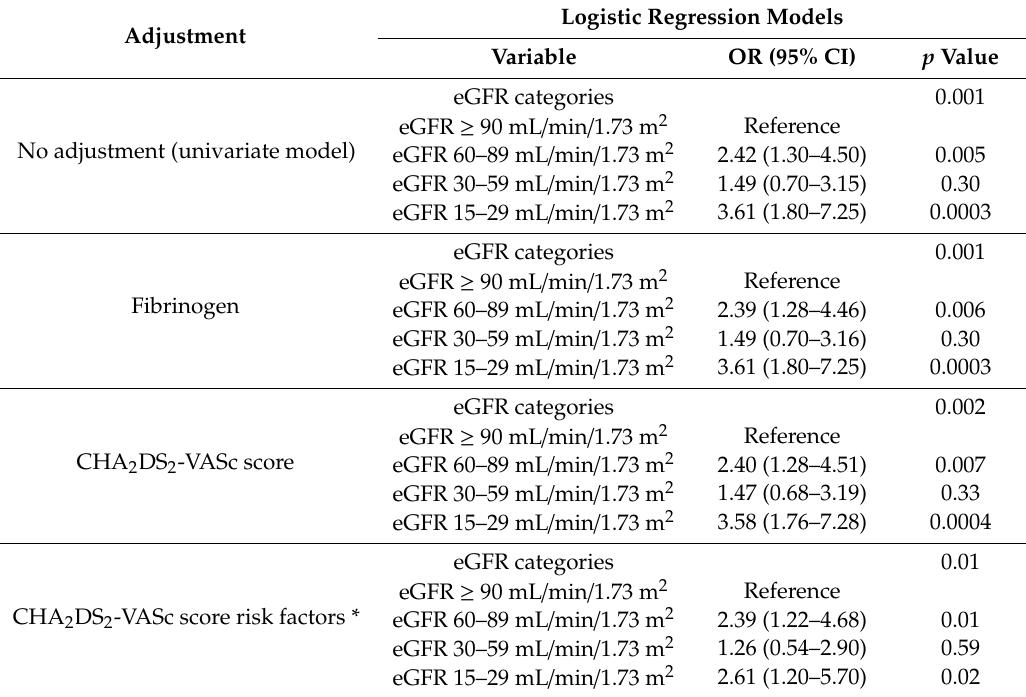
Table 5. Estimated glomerular filtration rate categories as predictors of prolonged clot lysis time (the top quartile, ≥ 108.3 min, n =